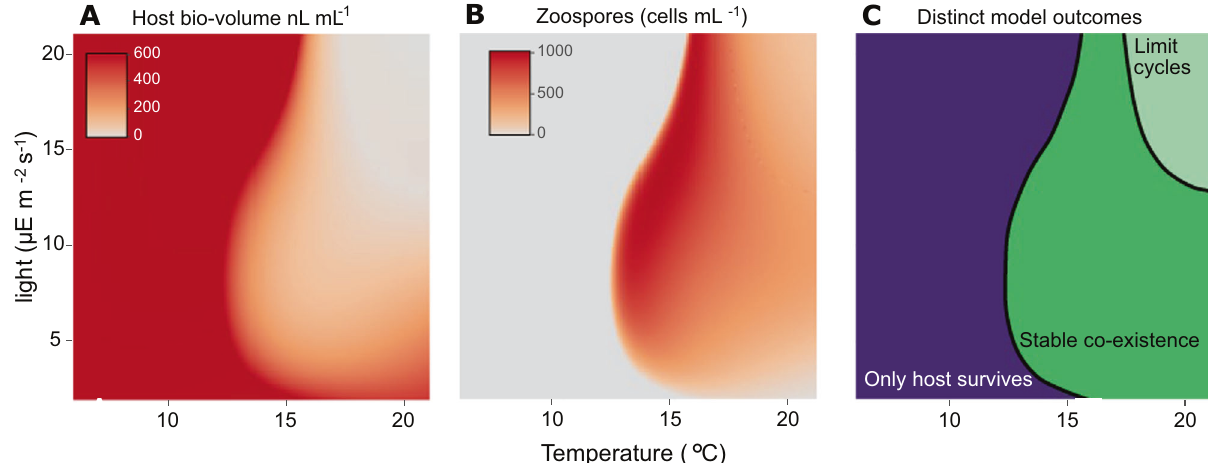
Fig. 3 Outcomes of modelled host-parasite dynamics in constant temperature and light conditions from our theoretical model. Figure 4 shows example time series from individual points on the temperature-light surface. A Host biovolume is greatest at temperatures below 13 °C and decreases above it. At high temperatures, host biovolume decreases with increasing light. B Chytrid zoospore abundance is highest at intermediate temperature and medium-to-high light levels. C The model shows 3 possible outcomes. The host persists alone at low temperatures, it exhibits limit cycles at high temperature and high light, and it coexists stably at intermediate conditions. Abundances shown in the limit cycle region for panel A and B are averages over the course of one cycle. Note that the model is intended to explore qualitative outcomes across parameter space and not to make precise quantitative predictions, for which additional factors (such as nutrients) would need to be (Fig. 2A), and increased growth of infected BV with higher growth of uninfected biovolume at 16 °C was higher than at 21 °C temperature (Fig. 2B). The effect of temperature is stronger at light. even though growth of P. rubescens in the uninfected treatment is At the lowest light level (2 μ E m − 2 s − 1 ), the effect of temperature is higher at 21 °C than at 16 °C (Fig. 2B). This indicates that at 21 °C P. rubescens is more vulnerable to chytrid infection than at 16 °C, absent, and the prevalence of infection is similar between 16 °C and especially at higher light levels. At 21 °C increased light also leads to 21 °C. Chytrid growth, as indicated by the growing fraction of a greater increase of the prevalence of infection compared to 16 °C. infected P. rubescens biovolume, was only higher at 21 °C than at We did not fi nd a low light refuge for P. rubescens . On the contrary, 16 °C with light levels at or above 14 μ E m − 2 s − 1 . Furthermore,